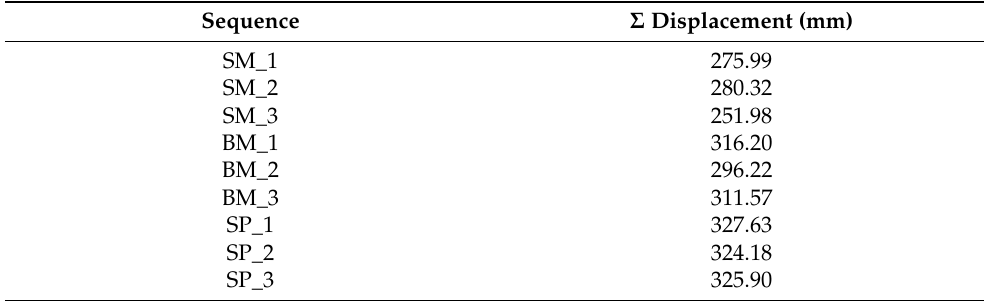
Table 8. Summation of sample distortions in butt-joint welding.